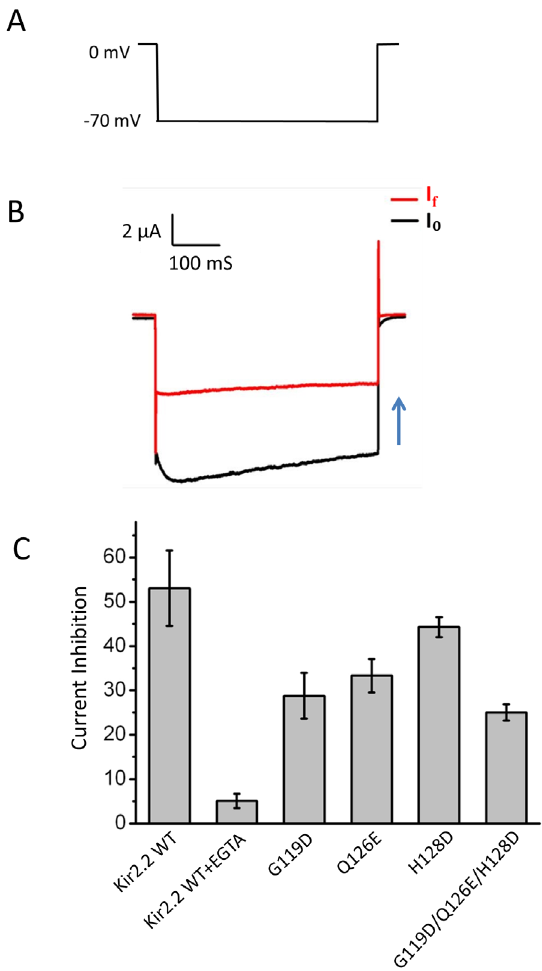
Figure 6. The mutants of Kir2.2 weaken the external Mg 2 + blockage. (A) The protocol used for recording the degree of inhibition which was hyperpolarization from 0 mV holding potential to 2 70 mV for 500 ms, and then stepped to 0 mV. (B) The representative currents trace in Kir2.2 channel. (C) degree of Inhibition ( c =(I 0 –I f )/I 0 ) for wild type (WT), WT + EGTA, G119D, Q126E, H128D and Triplet mutant (G119D, Q126E and H128D) channels.